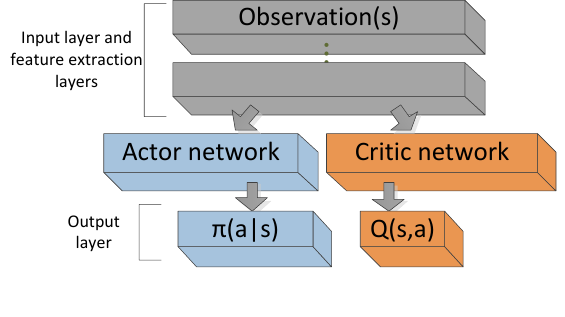
Figure 2. actor-critic